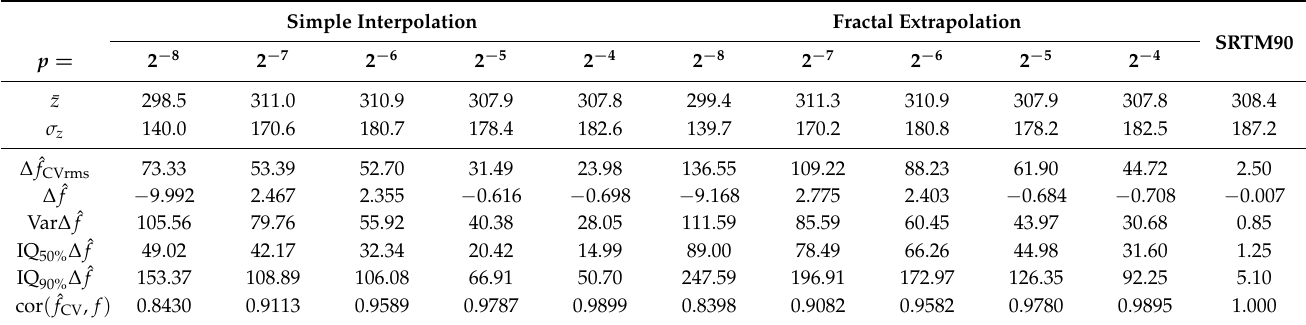
Table 2. K -fold and other statistics of interpolated DEM using simulated data extracted from SRTM along random 25 km transects; p denotes the fraction of the raster sampled by the transects. MMI was applied without and with fractal extrapolation. The SRTM90 column shows SRTM resampling error (see Table 1). Values are in